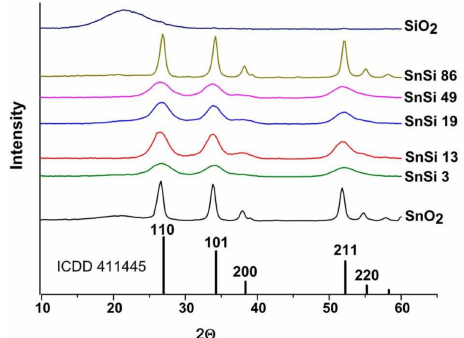
Figure 3. XRD patterns of nanocrystalline SnO 2 , SiO 2 and SnO 2 /SiO 2 nanocomposites. Vertical lines correspond to the ICDD 41-1445 reference (SnO 2